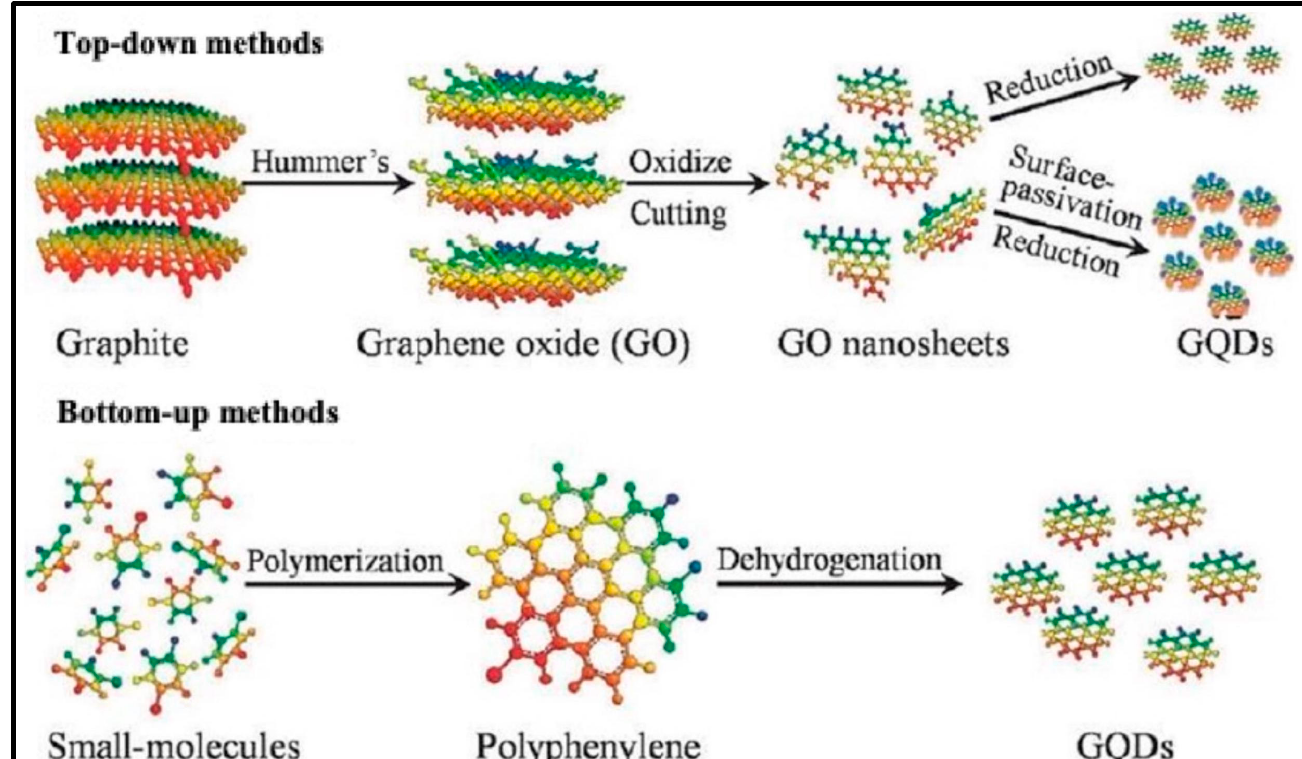
Figure 3. Schematic representation of GQD synthesis using top-down and bottom-up approach (Adapted from the Ref. [31] with the permission of ACS).